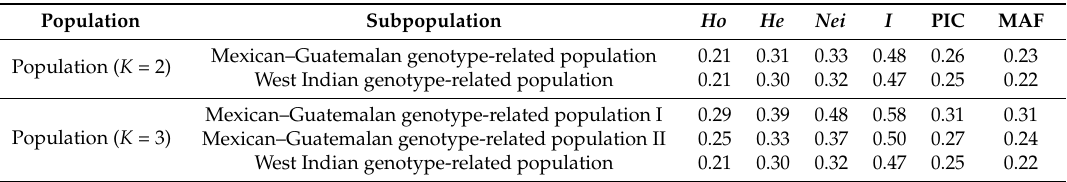
Table 2. Genetic diversity parameters of the different populations identified in 21 avocado accessions based on 70,1352 SNPs from